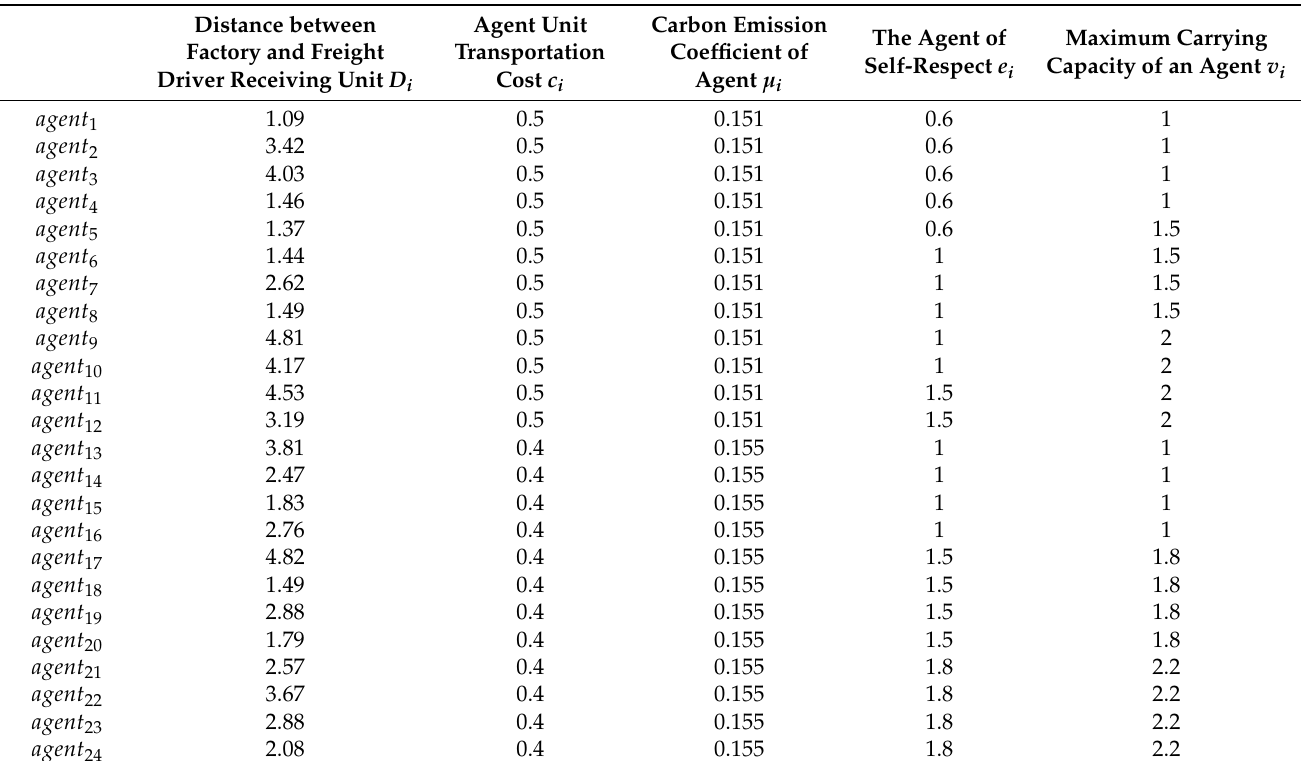
Table 4. Distance between the factory and carrier